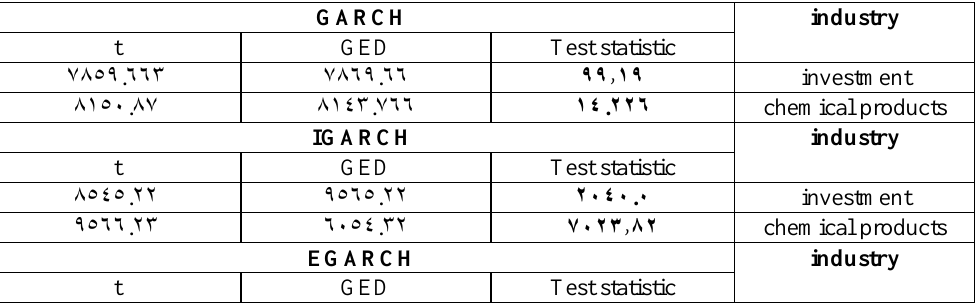
Table 12. Results of the Garcia–Perron likelihood ratio test in GARCH models by